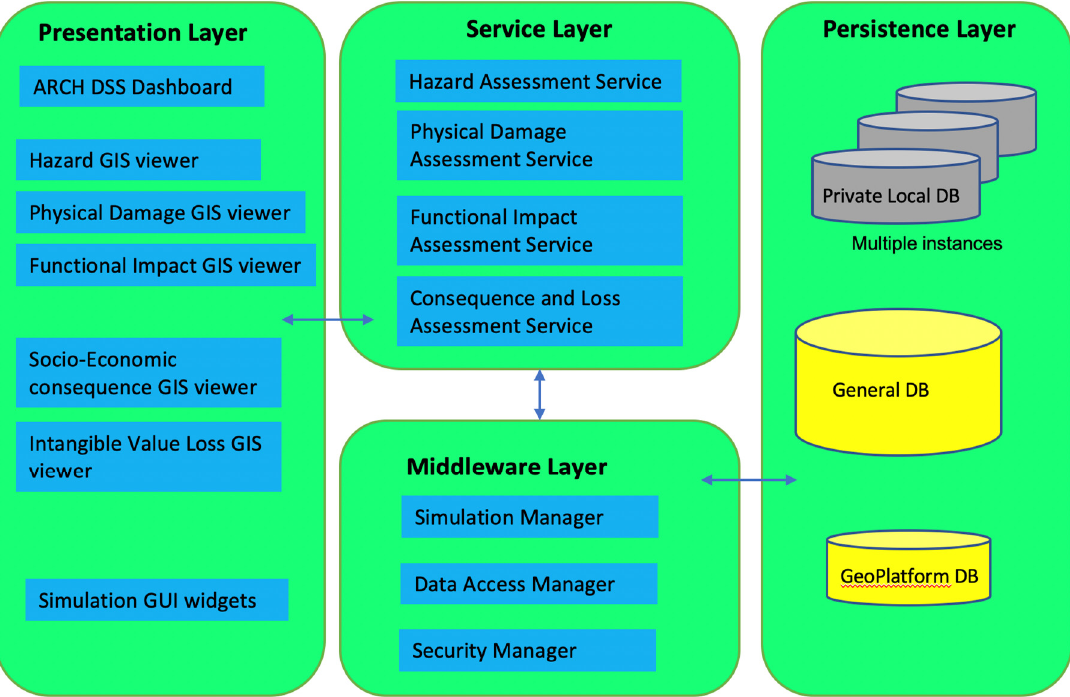
Figure 6. ARCH WebGIS DSS software architecture conceived as a multi-tier architecture including 4 layers: presentation, service, middleware, and persistence.